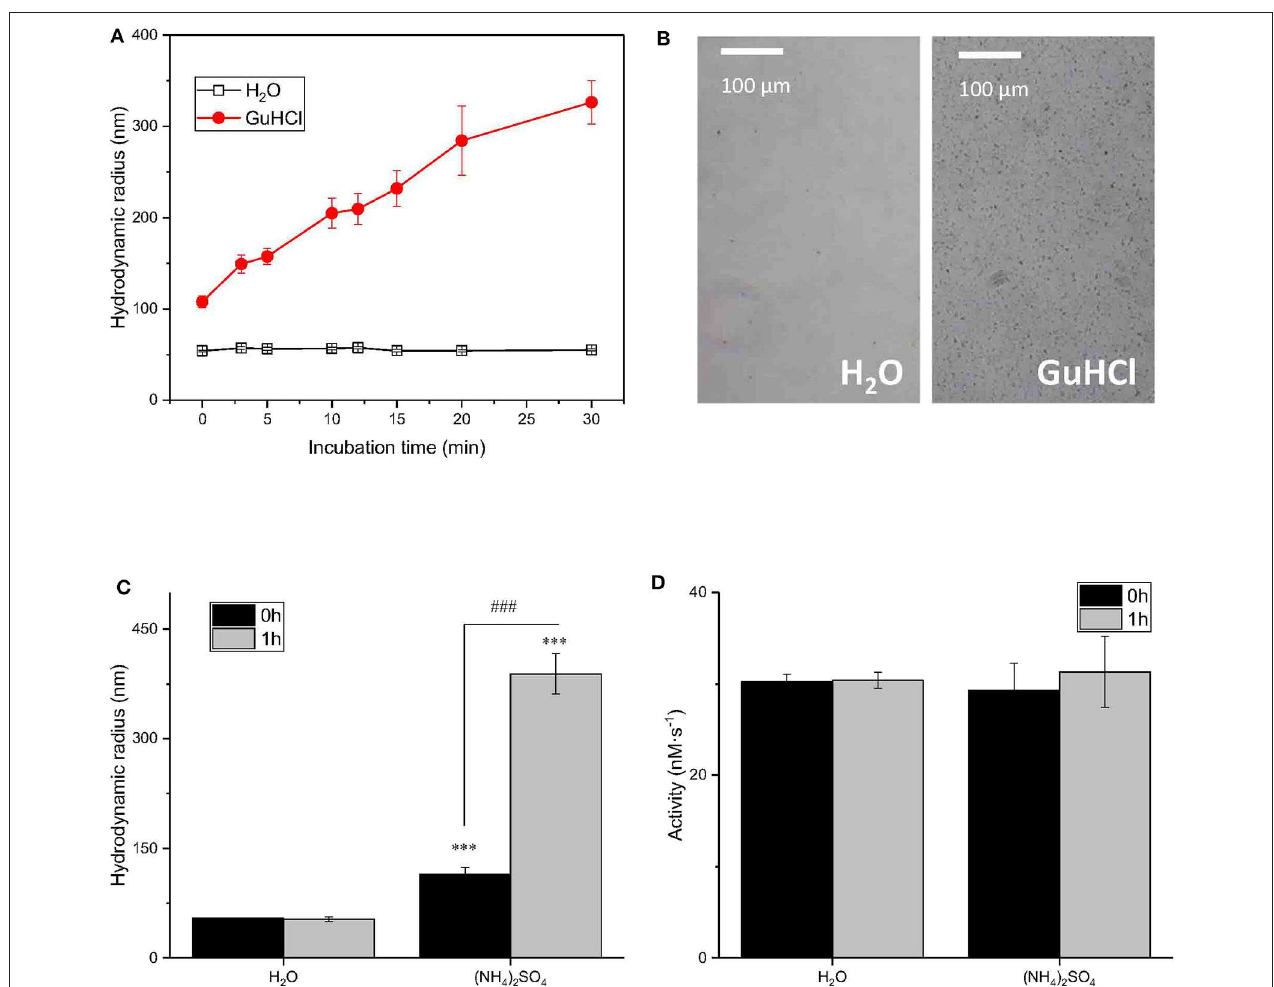
FIGURE 4 | The relationship between the IONzyme peroxidase-like activity and the radius. Dynamic light scattering was employed to measure the hydrodynamic radii of IONzymes. Time course of IONzyme hydrodynamic radii in H 2 O or 2M GuHCl (A) IONzyme aggregation was observed under a microscope after incubation the Nanozyme (0.91 µ g/100 µ l; concentration of Nanozyme in the Nanozyme-GuHCl incubation mixture before adding the reaction buffer) in 0.2M GuHCl for 24h (B) Comparison of IONzyme hydrodynamic radius (C) and peroxidase-like activity (D) in H 2 O or 0.5M (NH 4 ) 2 SO 4 with 0 or 1h pre-incubation time. *** P < 0.001 (vs. H 2 O − 0h). ### P < 0.001 (vs, (NH 4 ) 2 SO 4 −